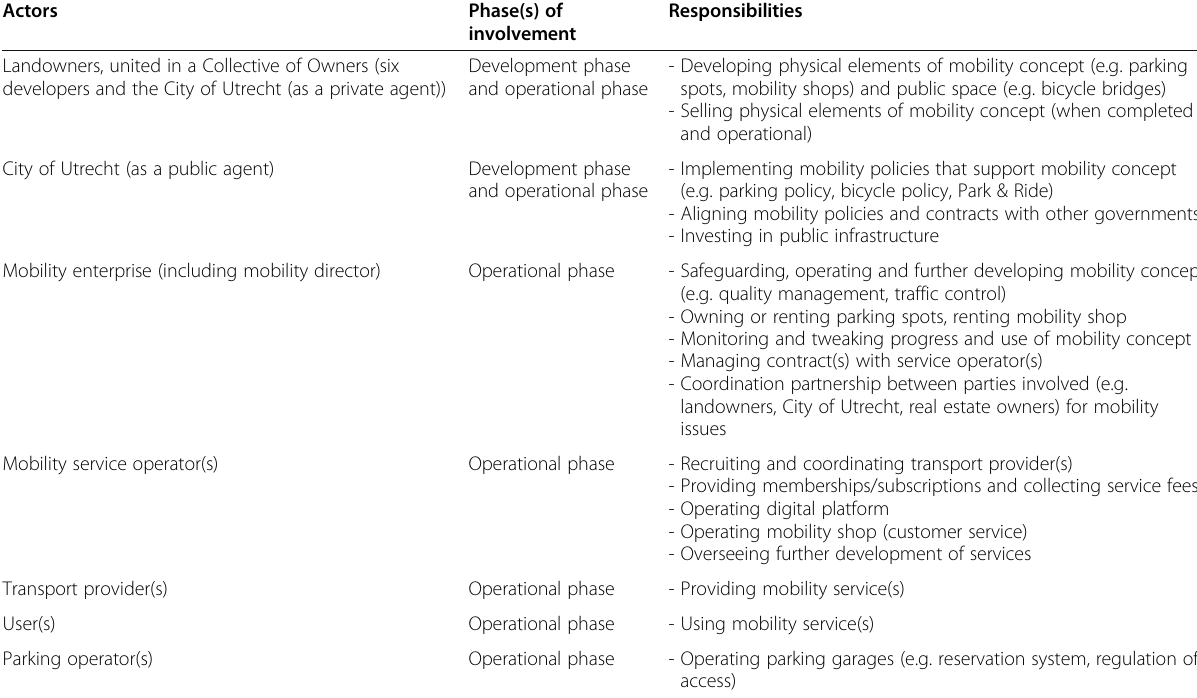
Responsibilities involvement Development phase - Developing physical elements of mobility concept (e.g. parking and operational phase spots, mobility shops) and public space (e.g. bicycle bridges) - Selling physical elements of mobility concept (when completed and operational)